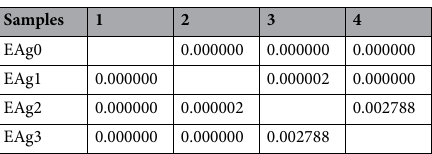
Table 10. Fisher LSD test for L* values in terms of different samples (nanosilver loading).